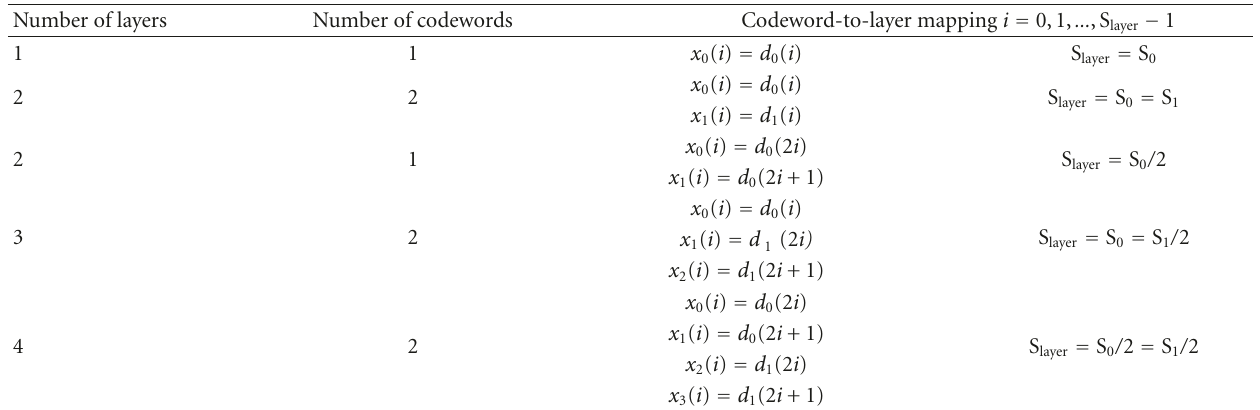
Table 3: Codeword-to-layer mapping for spatial multiplexing.